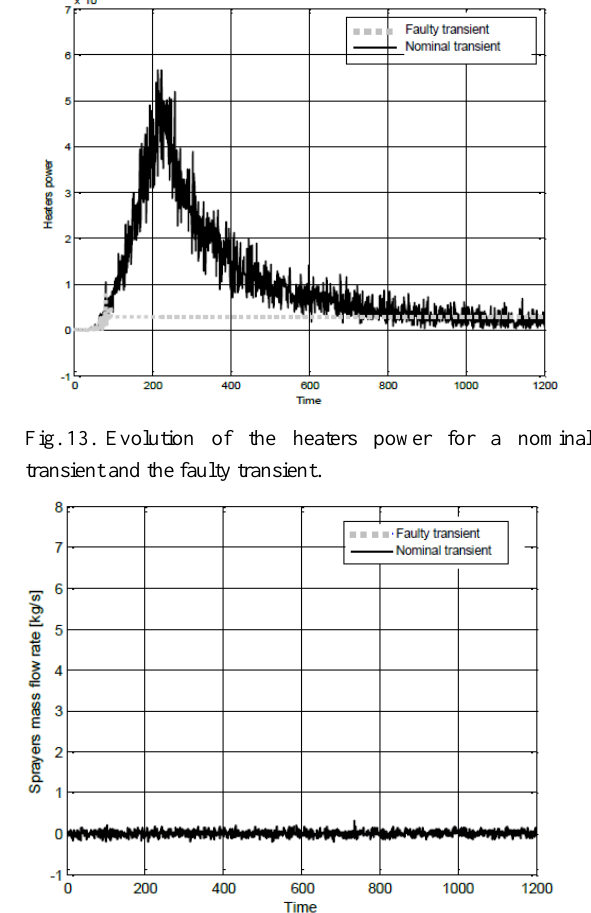
Fig. 14. Evolution of the sprayers mass flow rate.